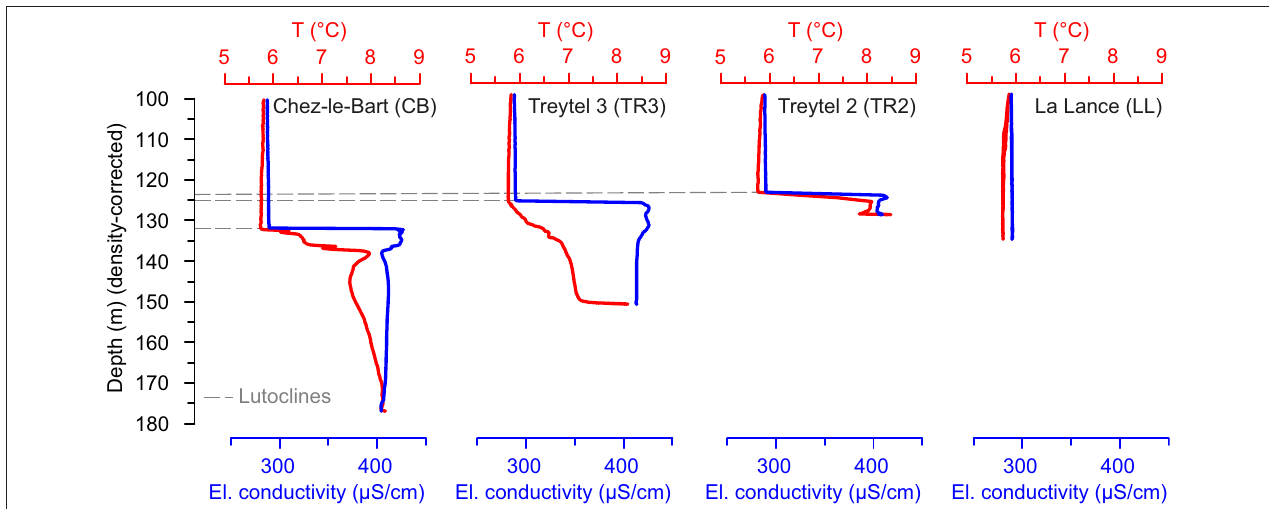
FIGURE 6 | CTD profiles at the locations of the CB, TR3, TR2, and LL pockmarks. Horizontal gray dashed lines mark the depth of the suspension surface at CB, TR3, and TR2 in the bathymetric data (see also Table 1